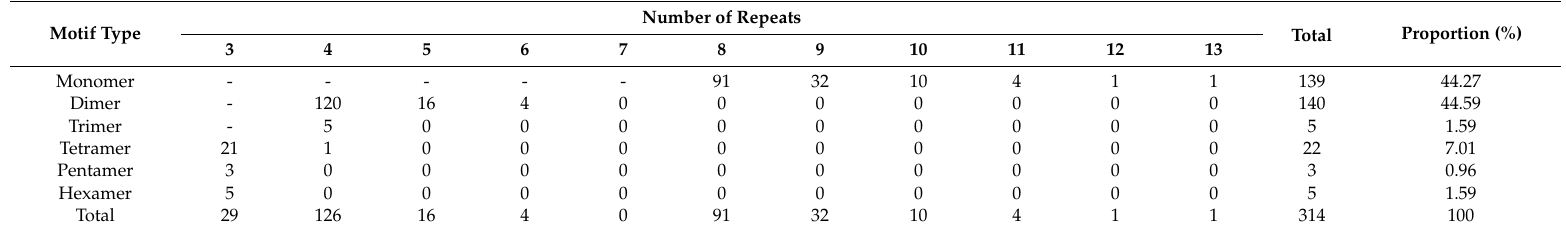
Table 4. Frequency of identified SSR motifs in P. vulgaris mitogenome.